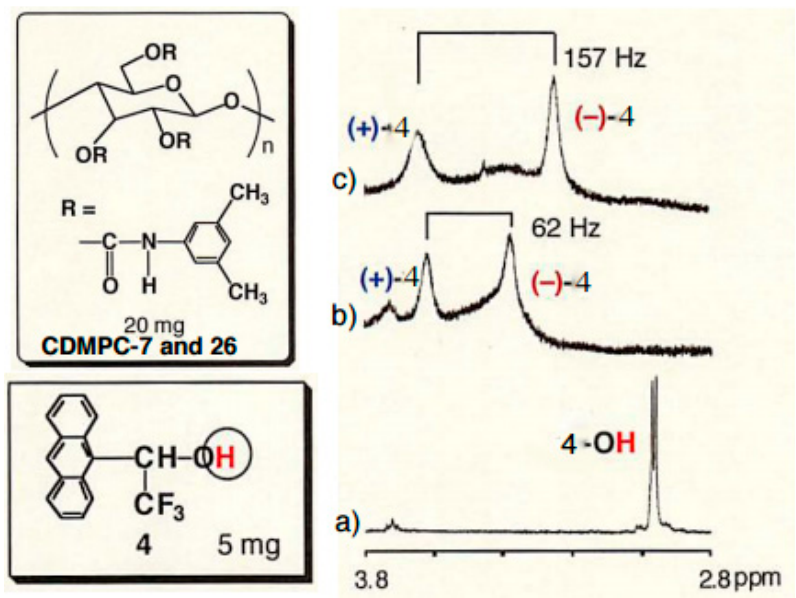
Figure 6. 1 H-NMR spectra of free 4 ( a ) and in the presence of CDMPC-7 ( b ) and CDMPC-26 ( c ) (400 MHz, 23 °C, chloroform- d 1 ).